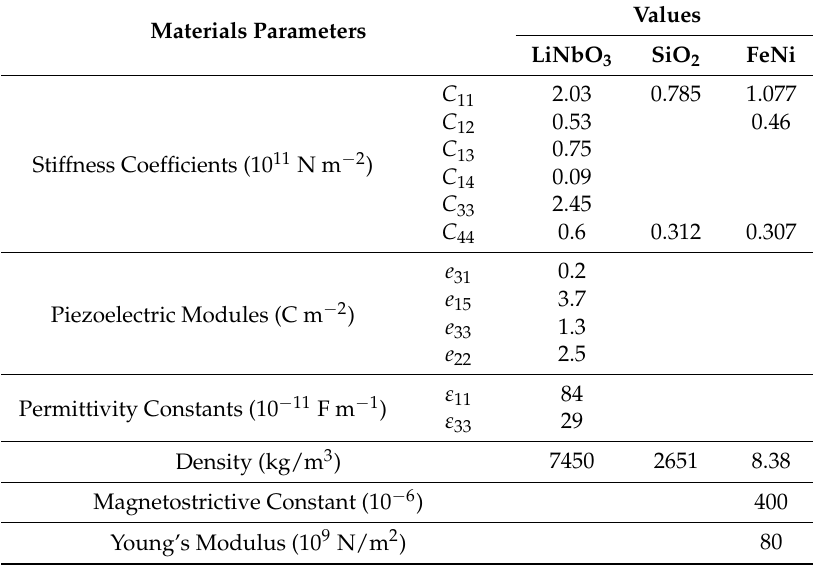
Table 1. Physical parameters of the piezoelectric substrate, SiO 2 , and FeNi. Materials